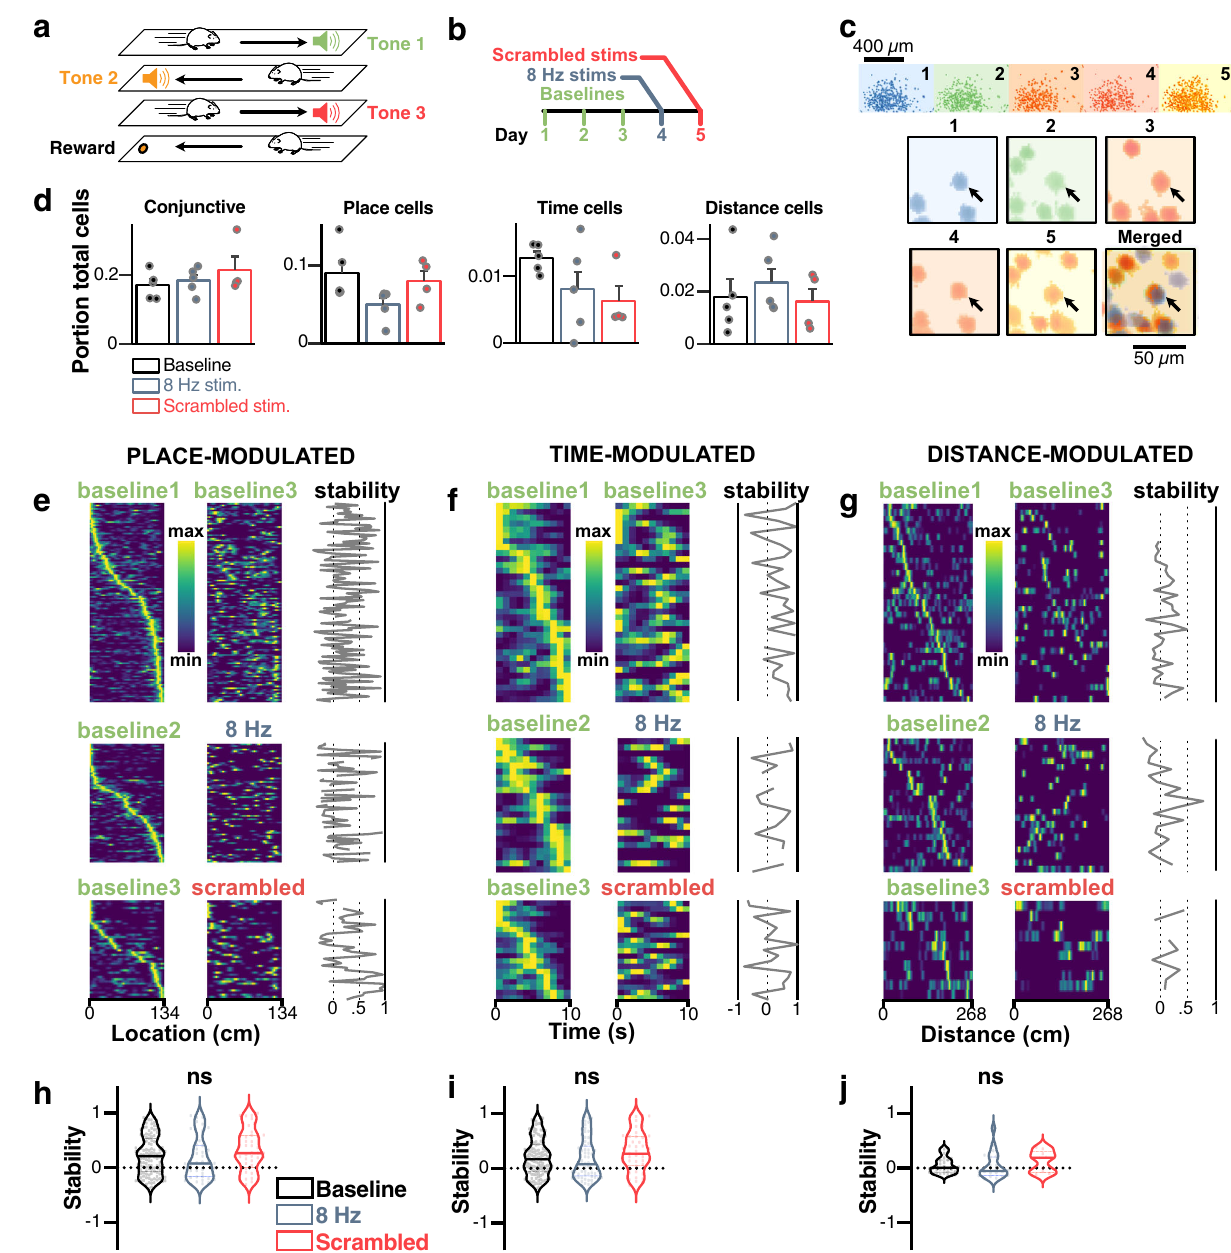
Fig. 5 | MS optogenetic stimulation does not disrupt the stability of spatio- temporal codes. a We recorded mice on the three-tone linear track to identify time-,place-,anddistance-modulatedcells(seeFig.1andMethods). b Experimental timeline. c Spatial footprints of neurons recorded over days and comparison scheme used to assess stability (top). Example neuron (black arrow) tracked over the fi ve experimental days (bottom). d Portion of total cells encoding for one or several (conjunctive) variables before and during 8Hz and frequency scrambling optogeneticstimulations( N =5mice). e Sortedplace fi eldsforidenti fi edplacecells across day pairs. The fi rst day is used as a baseline and mice undergo 8Hz, scrambled,or no stimulations (controltreatment)during the otherday. Stability is